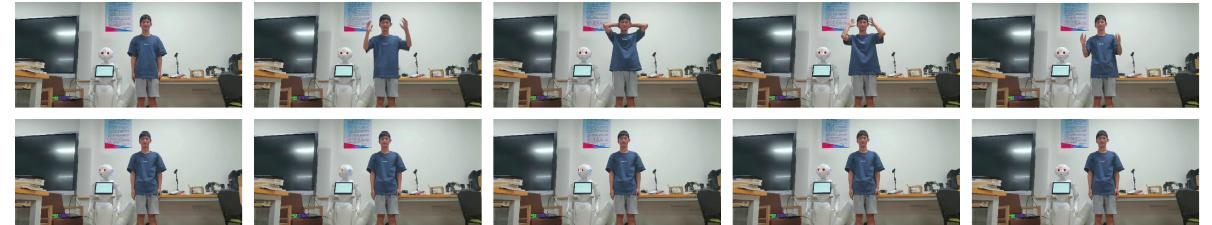
Figure 7: Action interaction with holding hands as an example.